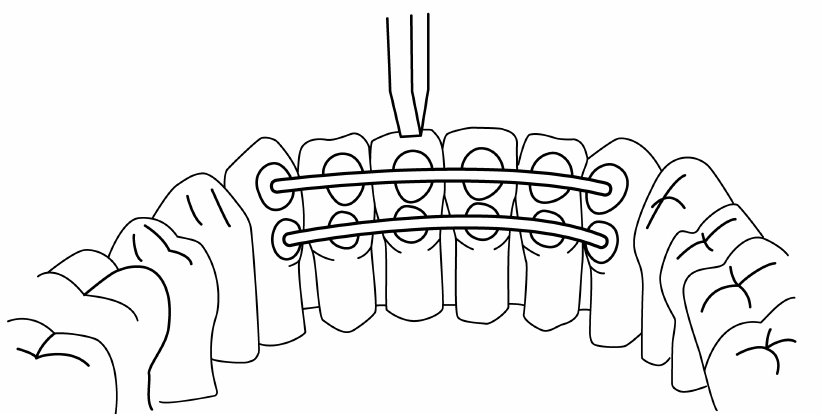
Figure 5. The loading test from the axial direction. In the example, the wires are bonded either 1–2 mm or 3–4 mm from the incisal edge of the teeth.